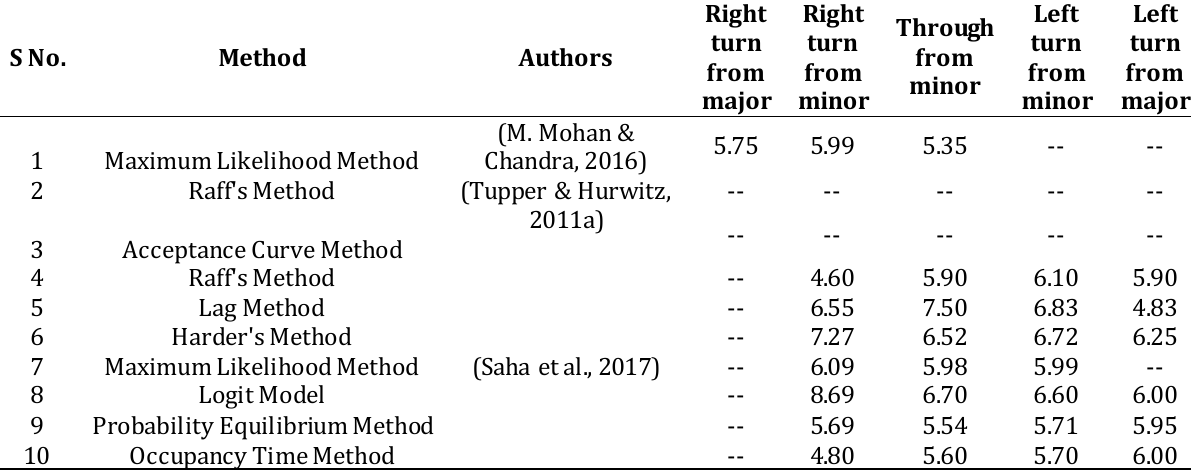
Table 7: Critical gap values for four arms uncontrolled intersection for homogeneous traffic condition in a developed country S No. Method Authors